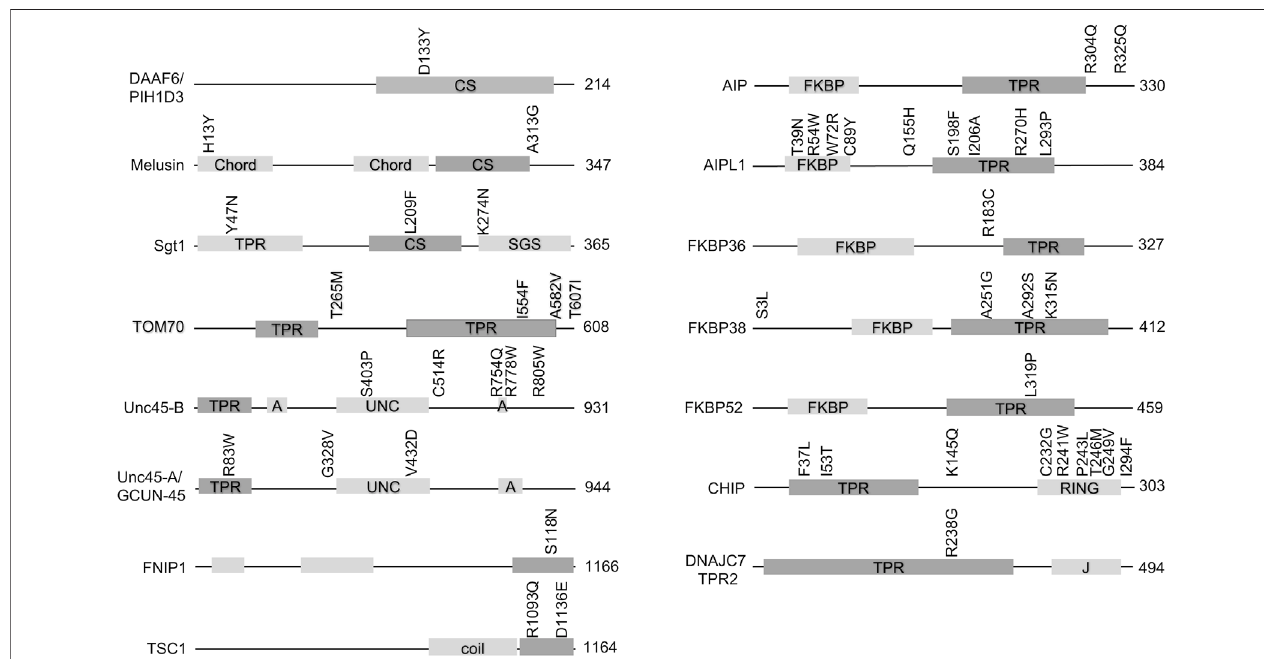
FIGURE 1 | Missense mutations in cochaperones linked to human disease. Schematic of cochaperone protein domains and the location of disease-associated mutations.Thesizeofeach protein(in aminoacidsisshown).Thedomain knownorpredicted tomediateHsp90interactionisshaded inthedarkercolor. Abbreviations: CS (cid:1) (Chord and Sgt1 like), Chord (Cysteine- and histidine-rich domains), TPR (tetratricopeptide repeat), SGS (Sgt1-speci fi c), A (armadillo), UNC (uncoordinated, myosin-interacting), coil (coiled-coil), FKBP (FK506-binding protein), RING (RING- fi nger U-box). J (cid:1) DnaJ-like domain).